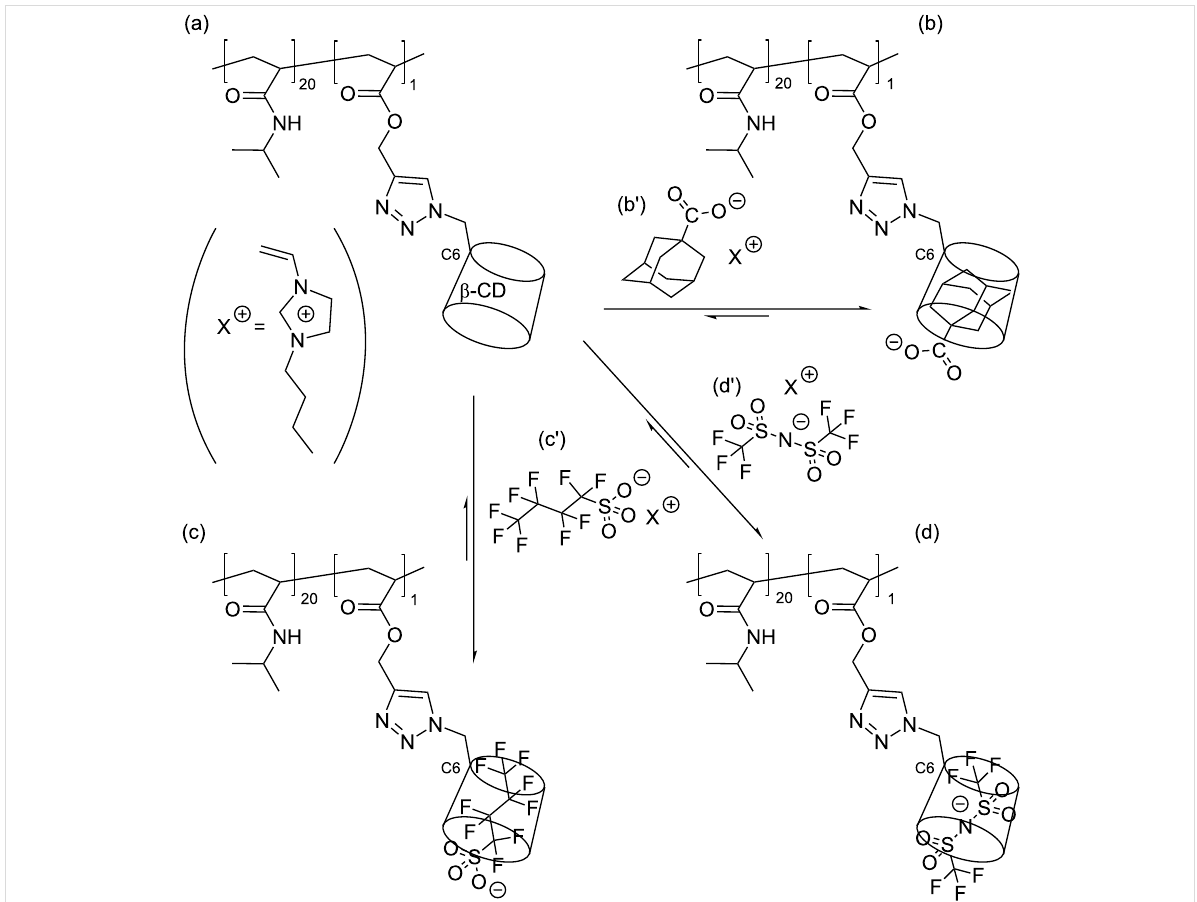
Figure 19: The copolymer of isopropylacrylamine and methacrylated β -CD (a) and its complexation of the anions of the ionic liquids 1-butyl-3-vinylimi- dazolium-adamantanecarboxylate, -bis(trifluoromethyl sulfonyl amide and -nonafluorobutansulfonate, (b’), (c’) and (d’), respectively to give the copolymer complexes (b), (c) and (d)